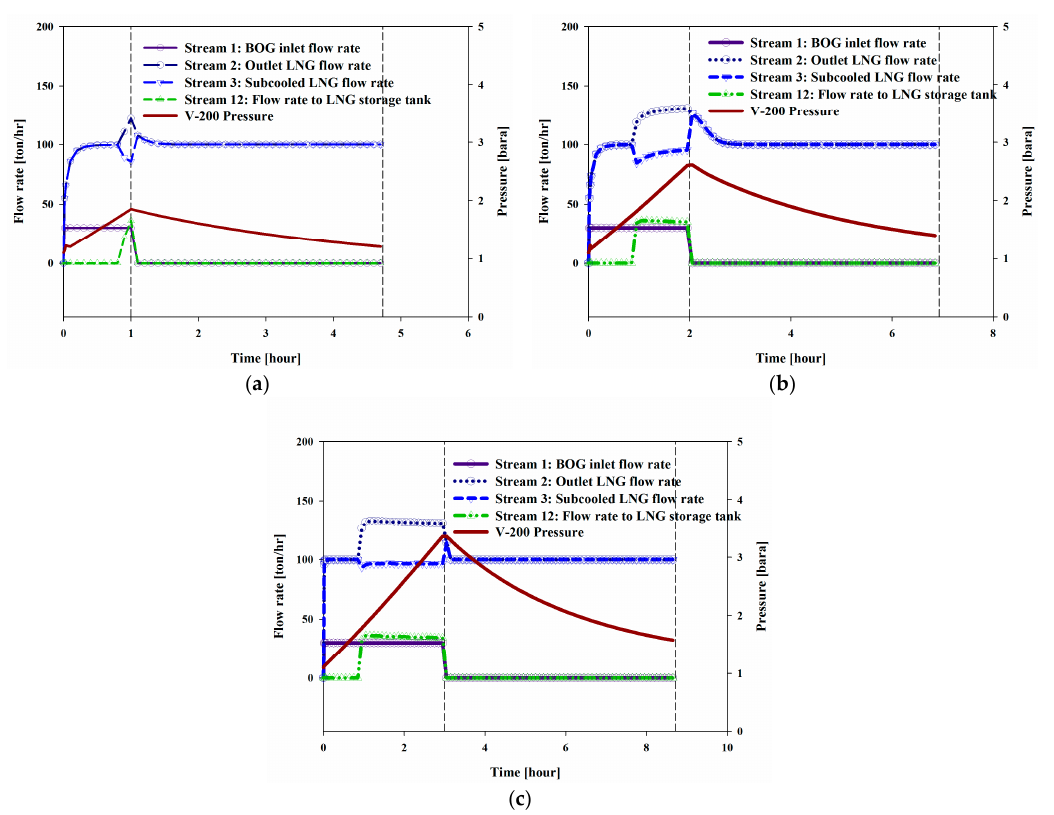
Figure 8. ( a ) Flow rate trends for DS-case I; ( b ) flow rate trends for DS-case II; and ( c ) flow rate trends for DS-case III and DS-case VI.